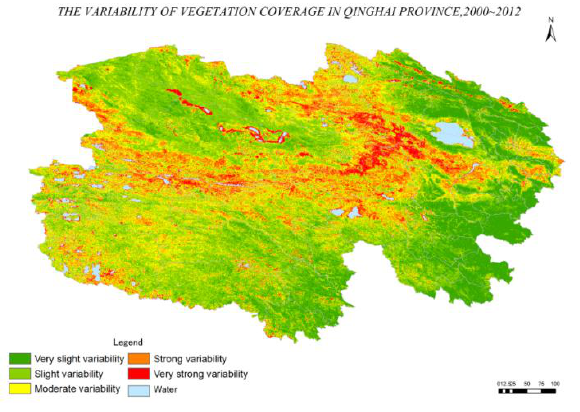
Figure 7. The variability of vegetation coverage during the period from 2000 to 2012 in Qinghai province